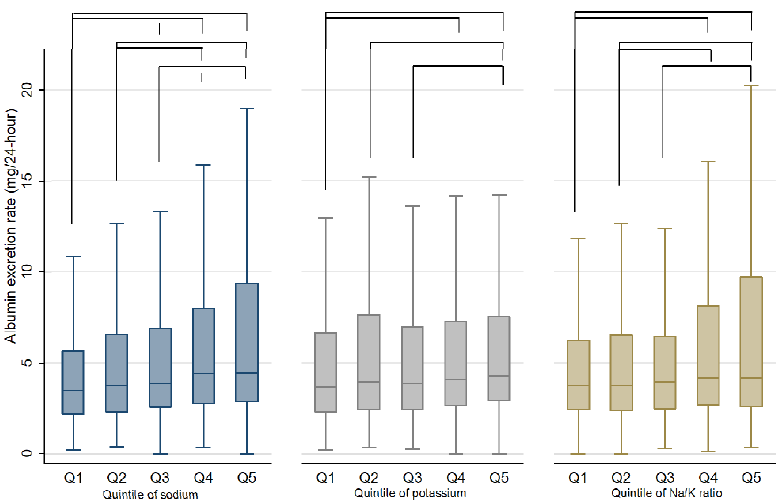
Figure 2. Box-and-whisker plots of 24-h urinary albumin excretion rate for the quintiles of sodium, potassium and sodium-to-potassium ratio. Notes: Q indicates quintile. The lines in the figure connected the pairs that exhibited significant difference for the distribution of AER in the Kruskal Wallis test. The adjusted p value for significance of multiple comparison between quintile groups was 0.0025. The pairs of significant difference were the follows. Sodium quintile: Q1 vs. Q3, Q1 vs. Q4, Q1 vs. Q5, Q2 vs. Q4, Q2 vs. Q5, Q3 vs. Q4, Q3 vs. Q5. Potassium quintile: Q1 vs. Q4, Q1 vs. Q5, Q2 vs. Q5, Q3 vs. Q5. Na/K ratio quintile: Q1 vs. Q4, Q1 vs. Q5, Q2 vs. Q4, Q2 vs. Q5, Q3 vs. Q5.